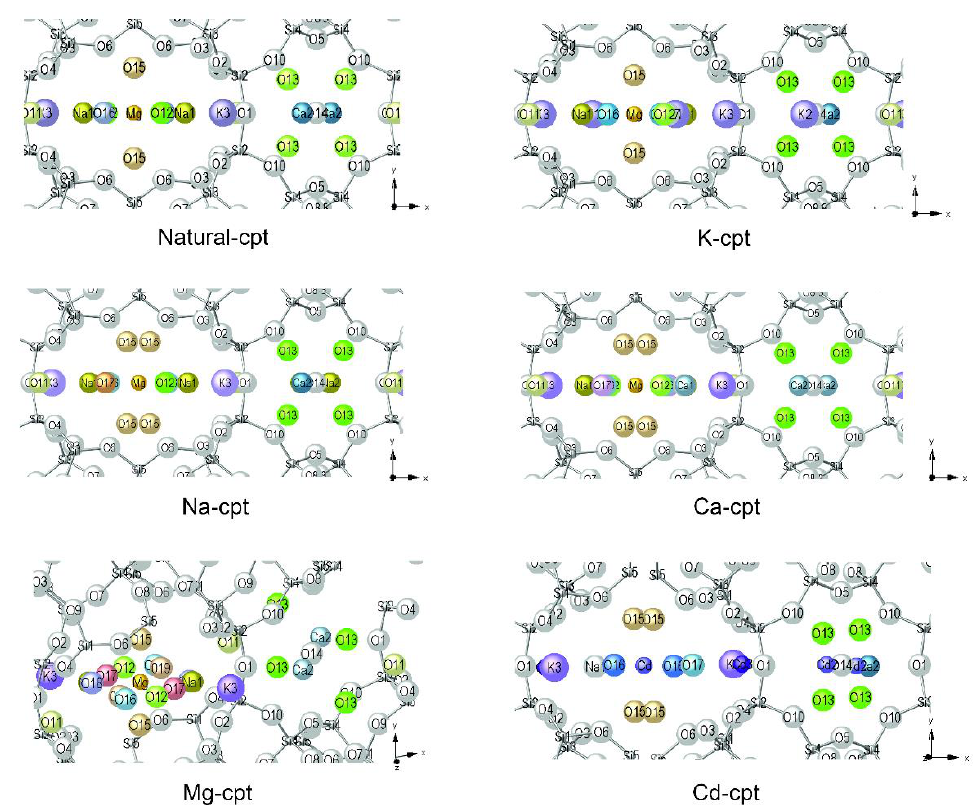
Figure 3. Structural representation of the refined cation-exchanged forms of the natural clinoptilo- lite.